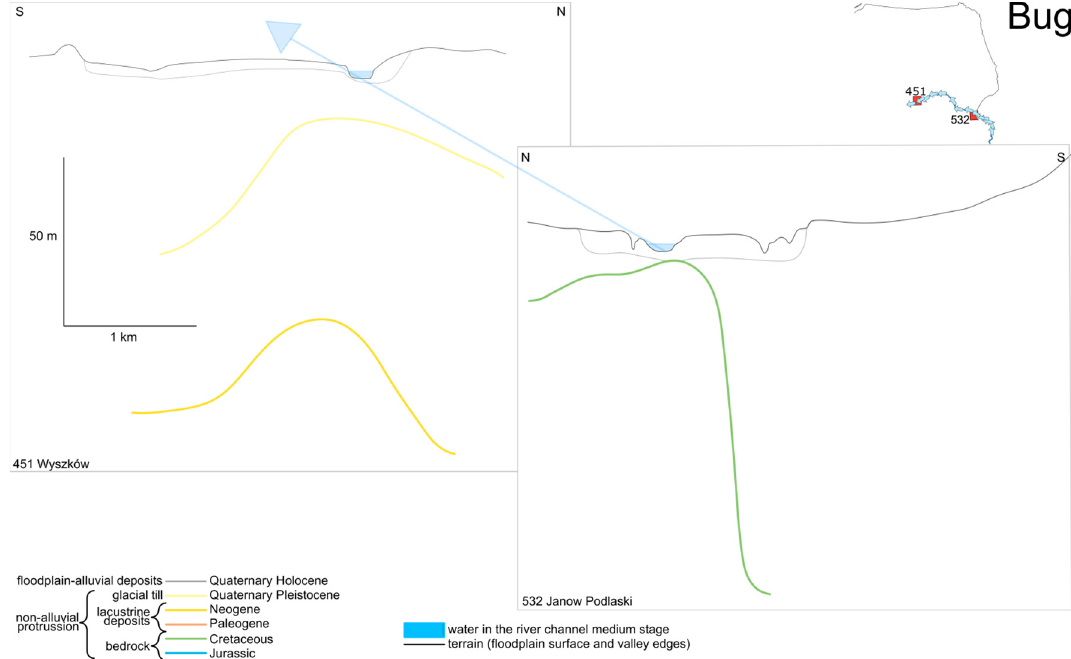
Figure 2. Geological cross-sections through the Bug river valley, according to [49,50]. Each cross-section presents: water in the river channel during medium stage (blue body); schematic river channel with flow direction (blue line) the valley profile graph with the floodplain surface and the valley’s walls (black), alluvial cover of the floodplain (grey) and non-alluvial protrusion underneath. The color of the non-alluvial protrusion indicates its age according to the stratigraphic chart [43].